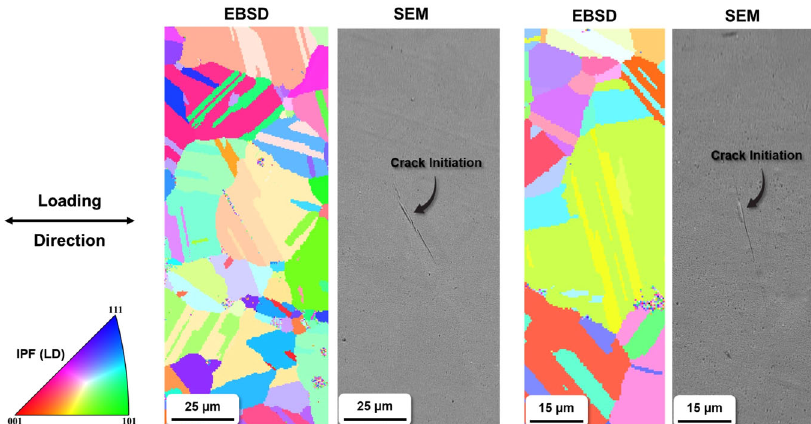
Fig. 2 Two sample experimental data sets used in the development of the Bayesian crack nucleation model. The SEM images display fatigue crack nucleation near and parallel to the twin boundaries. The associated EBSD maps present the grain structure around the crack nucleation